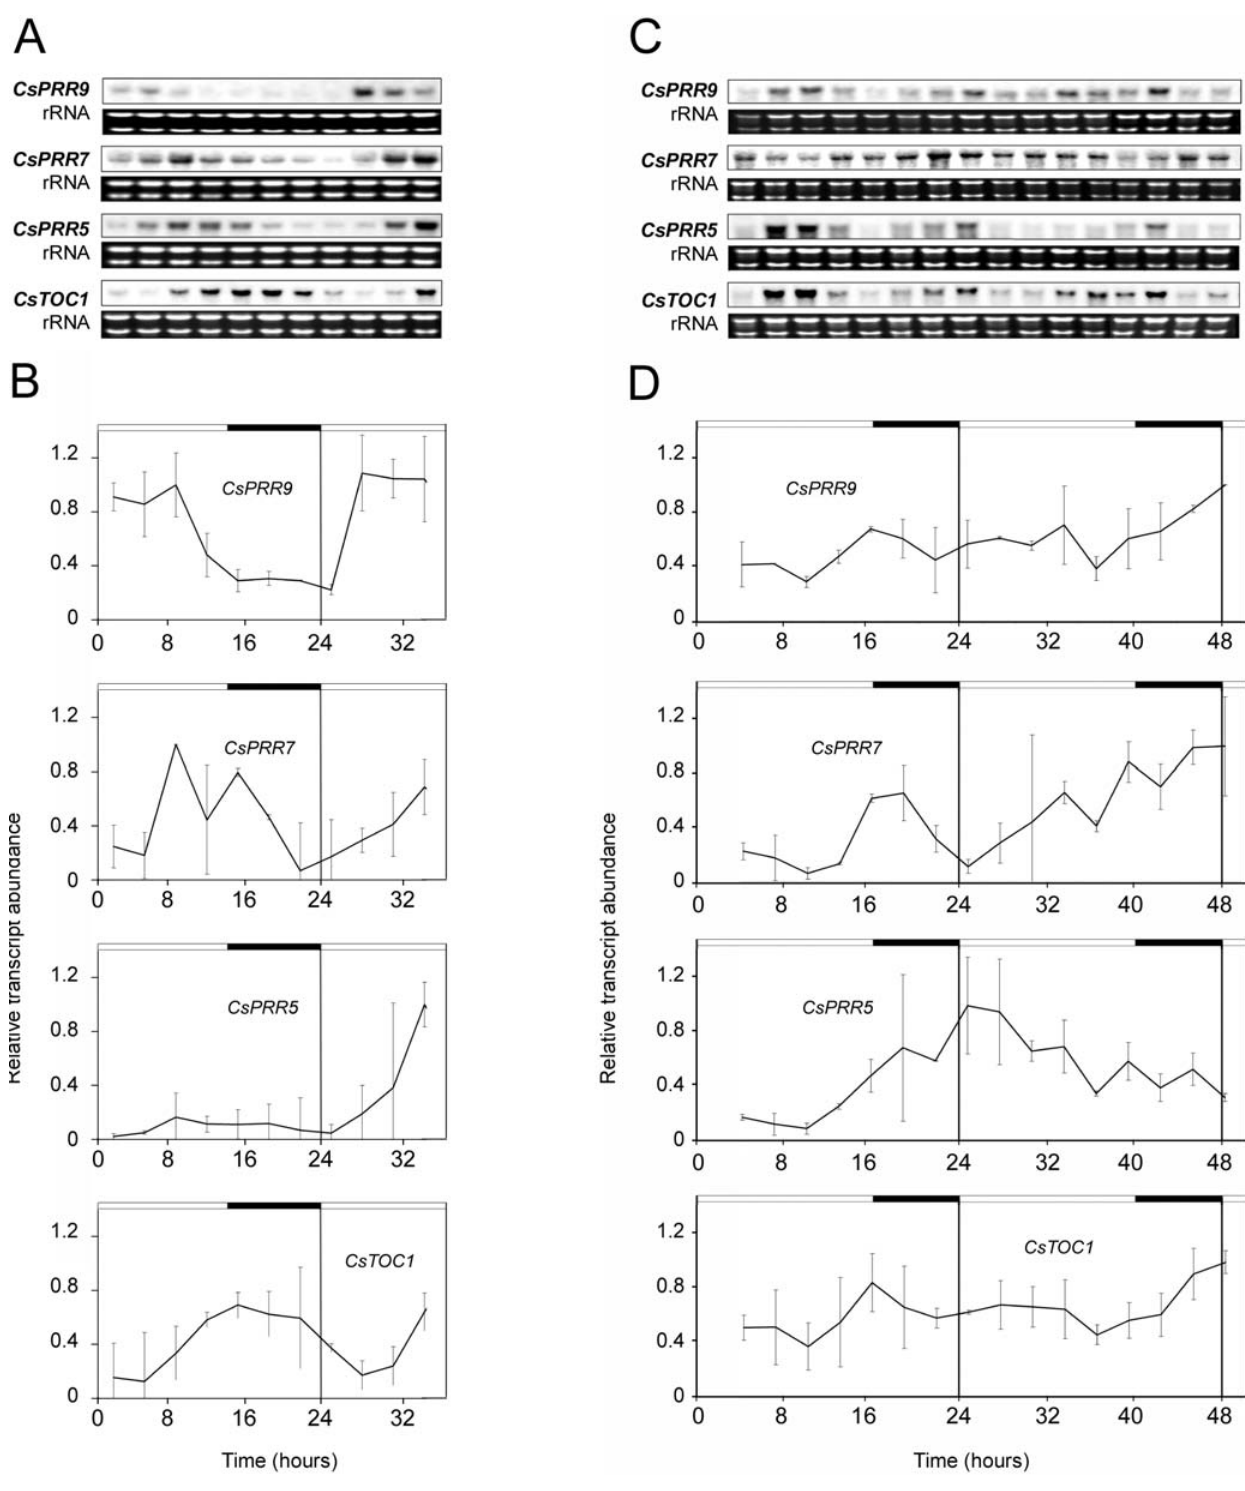
Figure 5. CsPRR gene expression in the stems of chestnut seedlings grown under different temperature conditions. The figure shows CsPRR blot analysis and mRNA abundances. ( A and B ) Stems from seedlings grown under conditions of LD and 22 u C. ( C and D ) Stems from seedlings grown under standard conditions (LD, 22 u C) and subsequently subjected to one week of LD at 4 u C. Samples were collected at 3-h intervals. ( A and C ) CsPRR northern blot analysis. The rRNA loading reference was detected by staining gels with ethidium bromide. ( B and D ) Quantitative RT-PCR analysis. Relative transcript abundances are shown in the graphs. Data are means from two biological replicates. Open and filled bars above each graph indicate lights on and lights off, respectively.